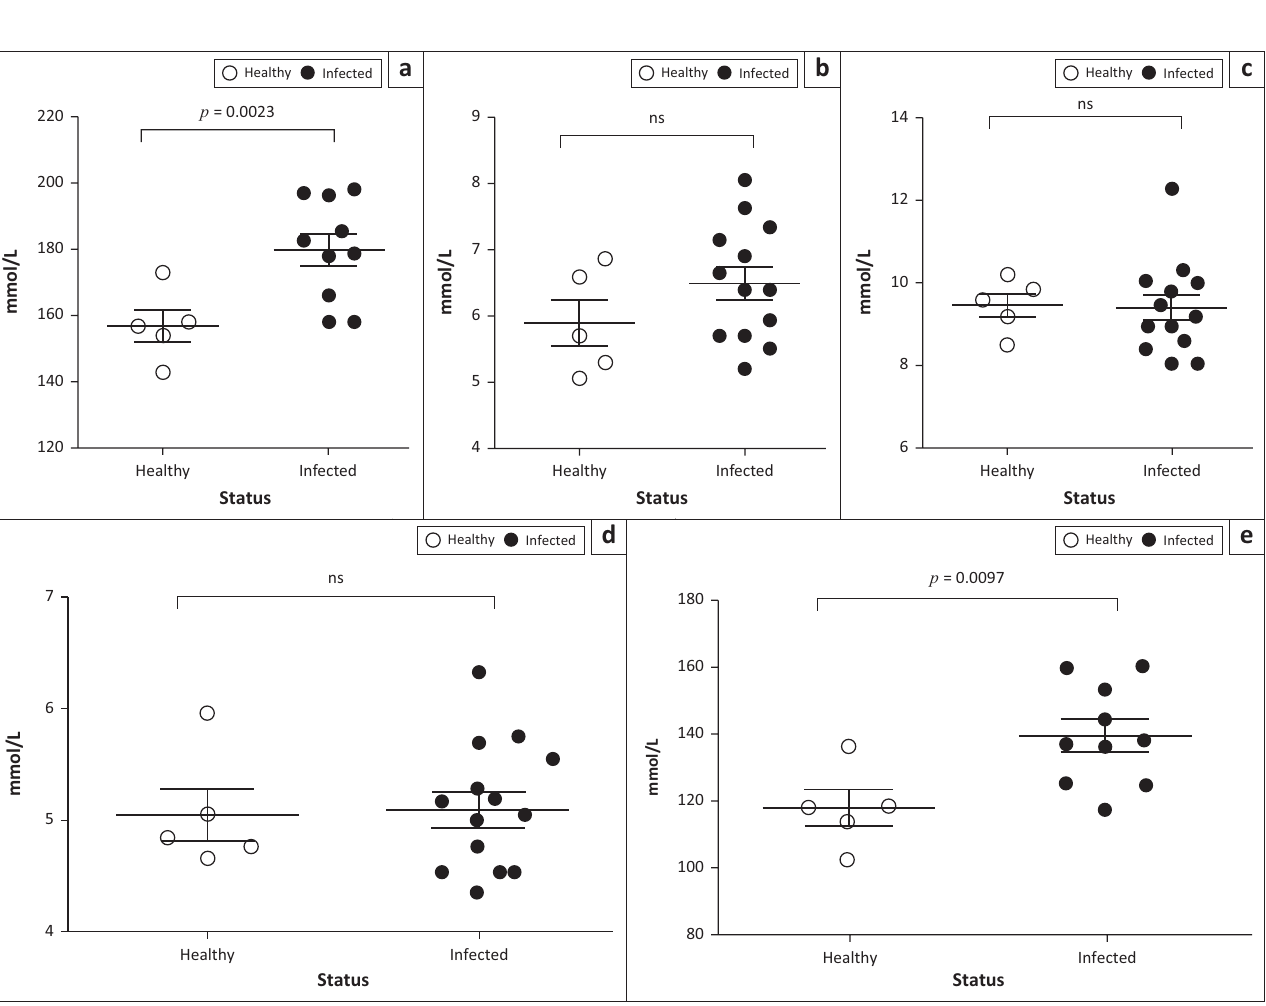
FIGURE 6: Serum electrolytes analysis of natural peste des petits ruminants virus–infected Black Bengal goats showed elevated level of sodium and chloride ions. Serum samples were collected from healthy and PPR-affected goats and the values of (a) sodium, (b) potassium, (c) calcium, (d) phosphorus and (e) chloride were quantified. Data indicate mean ± SEM from 5 healthy and 10–13 peste des petits ruminants virus–infected goats. One-tailed Mann–Whitney test. p ≤ 0.05 was considered statistically